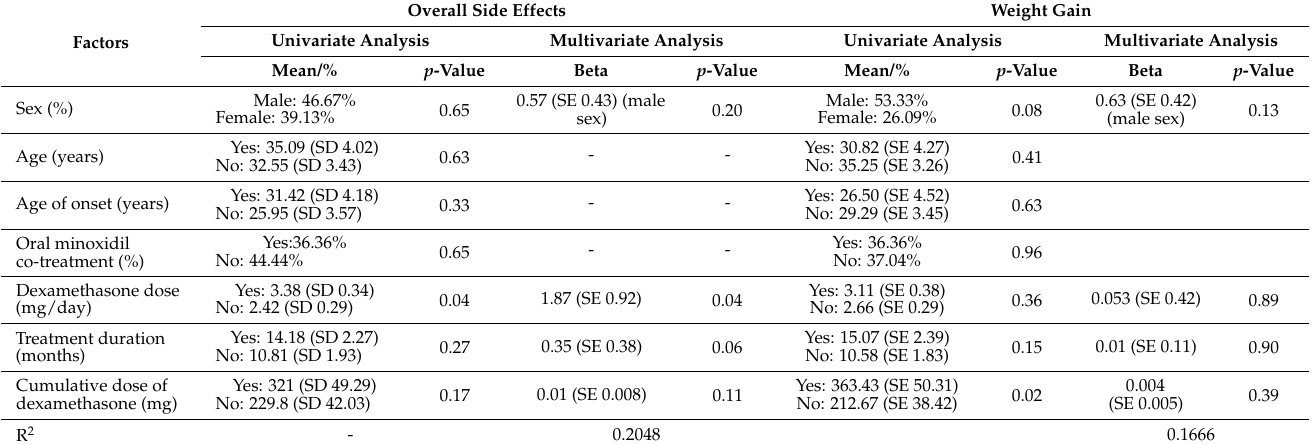
Table 4. Side effect-associated factors during dexamethasone